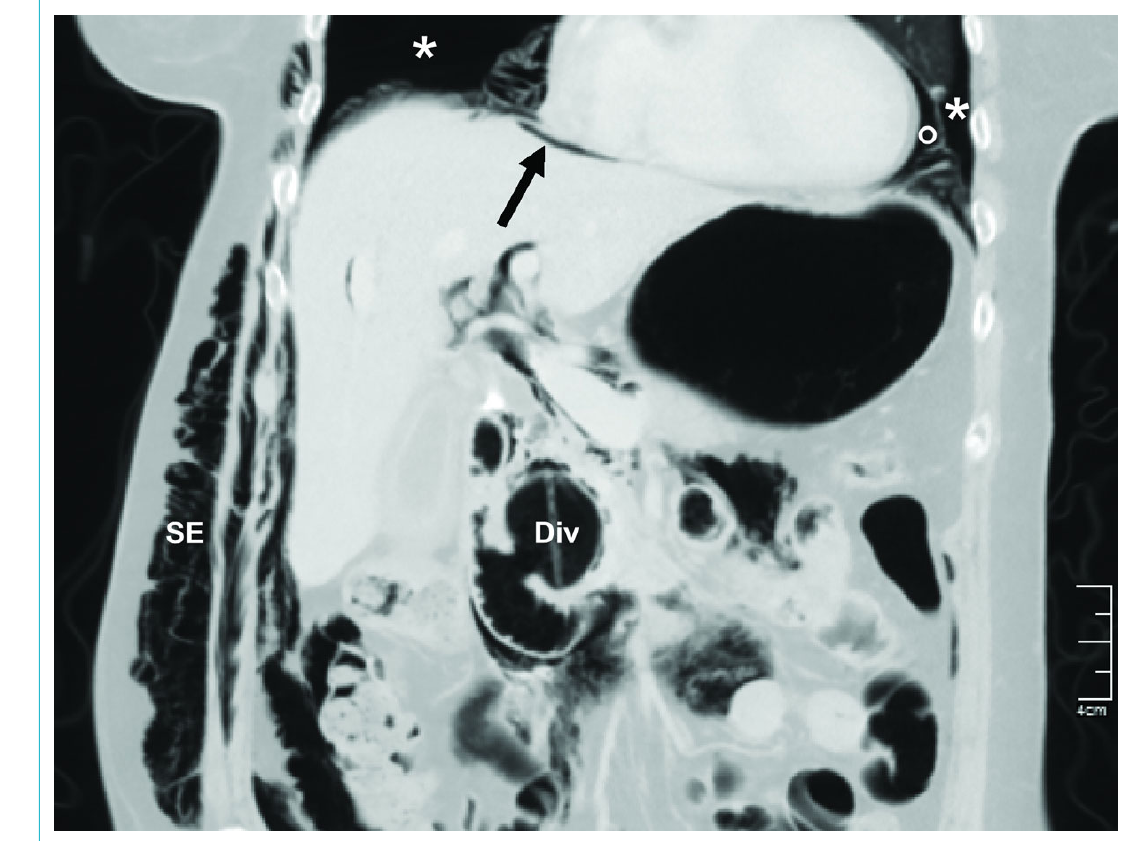
Figure 3: Post-ERCP abdominal computed tomography scan of a 75-year old patient at our institution demonstrating bilateral pneumotho- races (*), pneumomediastinum (°), pneumoperitoneum (arrow), and subcutaneous emphysema (SE). A peri-ampullary diverticulum (Div) is